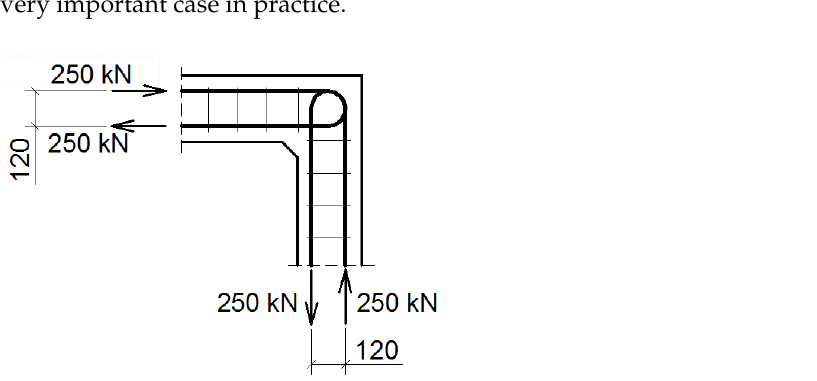
Figure 14. Geometry and main reinforcement for the case of elements with different cross section heights; dimensions in (mm).